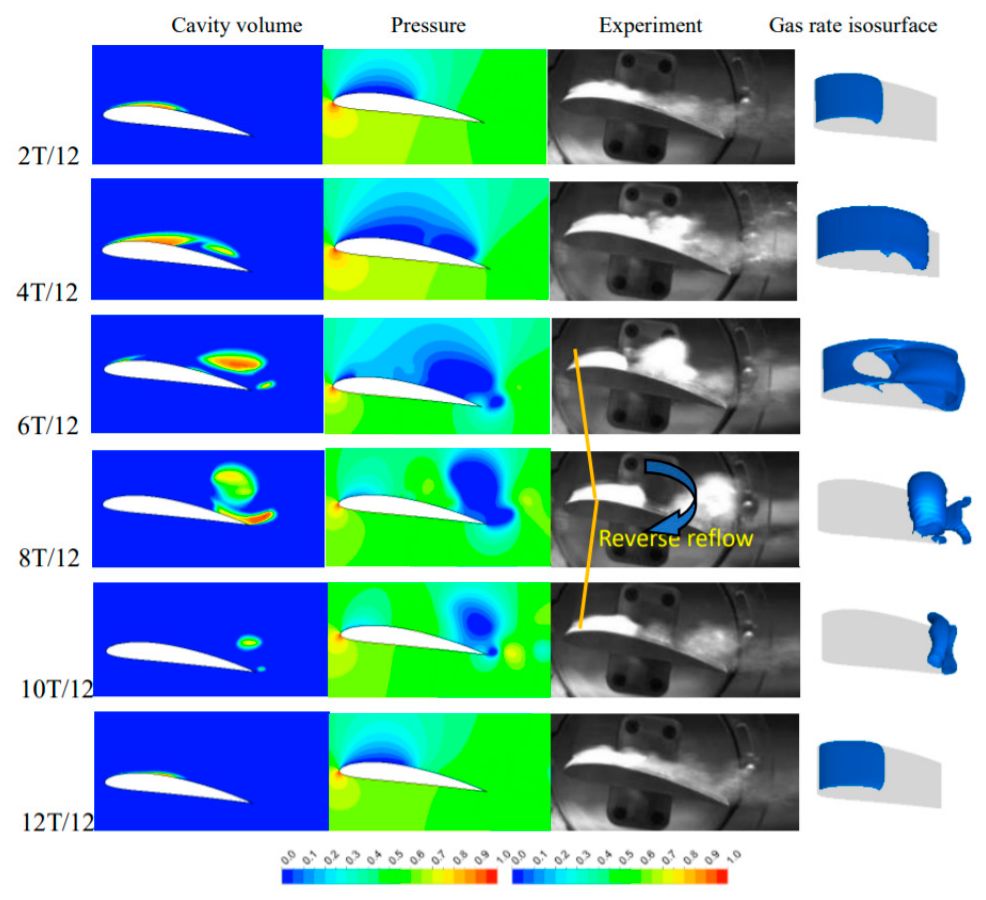
◦ attack angle hydrofoil (gas rate isosurface α